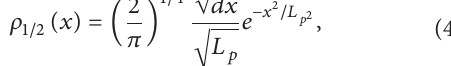
This simplified illustration provides us with a